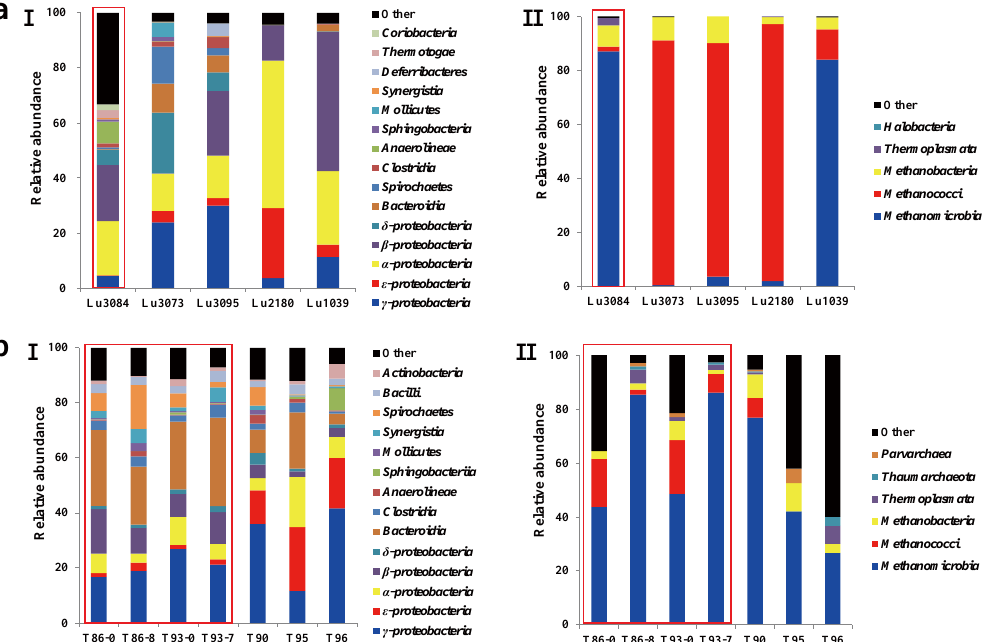
Figure 2. Relative proportion of microbial taxa at class level in the injected and produced water samples. (a) Sandstone and (b) conglomerate reservoirs. (I) Bacterial taxa at class level; (II) archaeal taxa at class level; Lu3084, T86-0, and T93-0: water samples from the well head of the injection wells; T86-8 and T93-7: water samples from downhole of the injection wells; T90, T95, T96, Lu1039, Lu2180, Lu3073, and Lu3095: water samples from the well head of the production